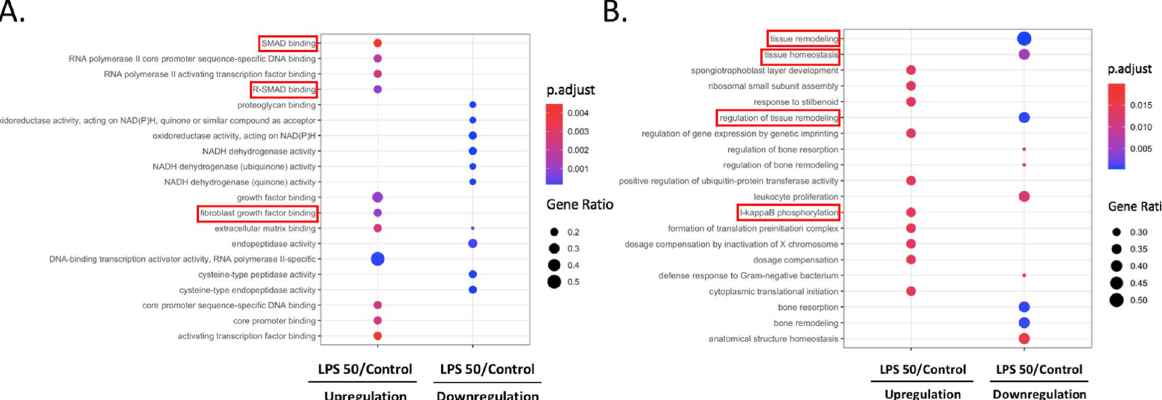
Fig. 6 RNA sequencing of ex vivo fetal lungs treated with lipopolysaccharide (LPS). A Gene ontology (GO) analysis of molecular functions of genes by LPS at 0 and 50 μg/ml for 3 days. B GO analysis of biologic pathways of genes by LPS at 0 and 50 μg/ml for 3